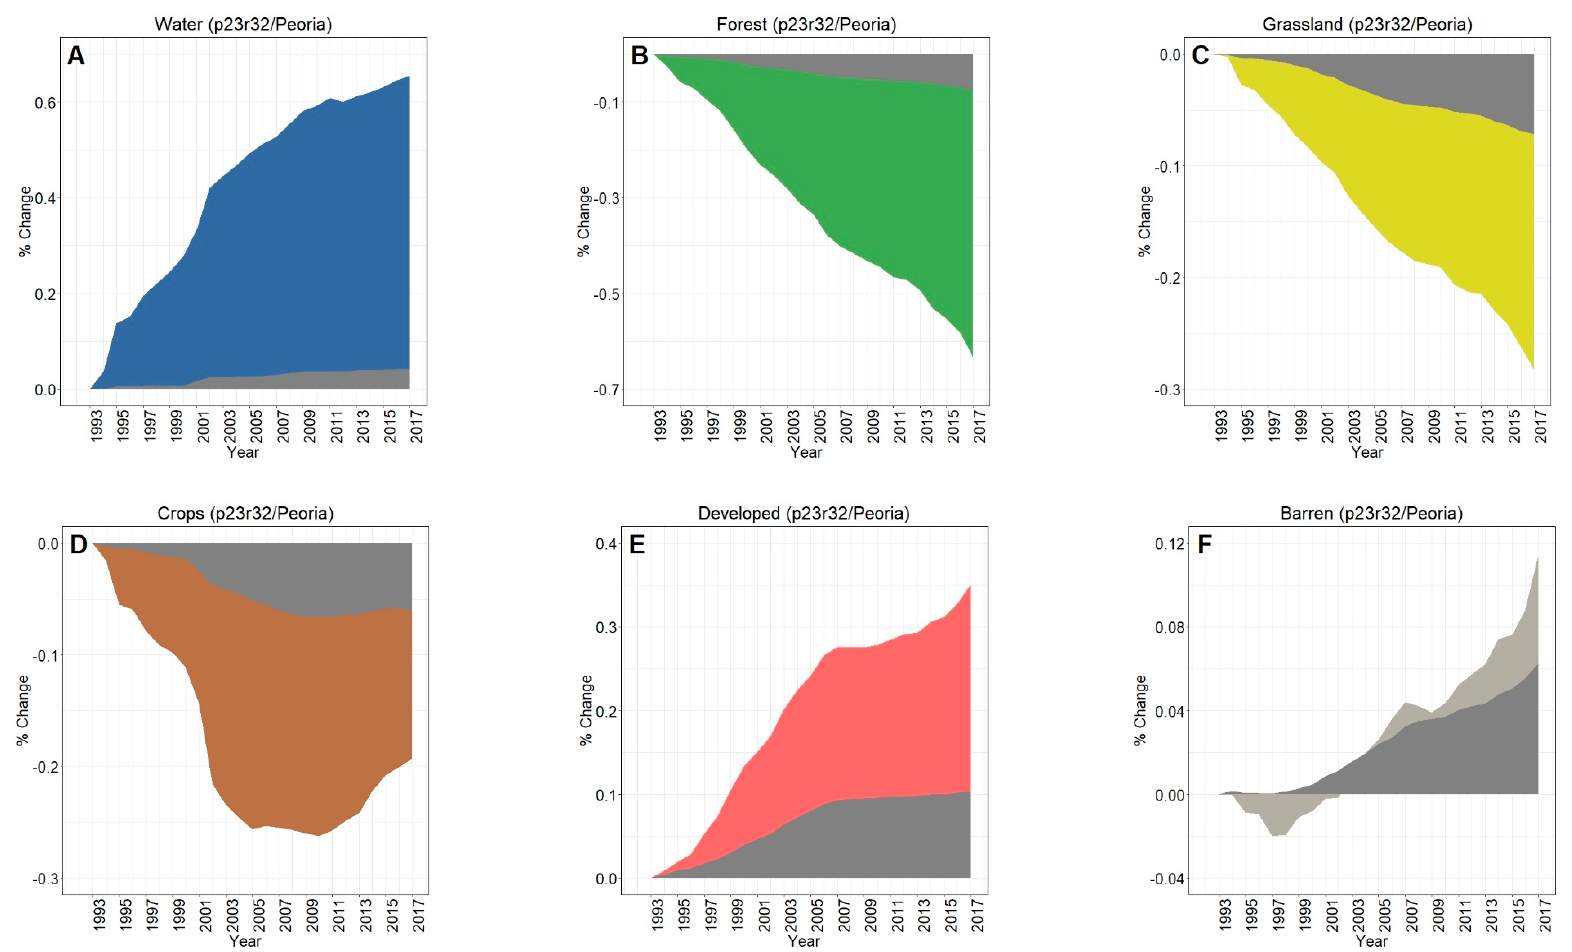
Figure 10. Contrasting LULC change in the areas buffering waters with the Peoria-area footprint-wide change for ( A ) water, ( B ) forest, ( C ) grassland, ( D ) crops, ( E ) developed, and ( F ) barren classes.